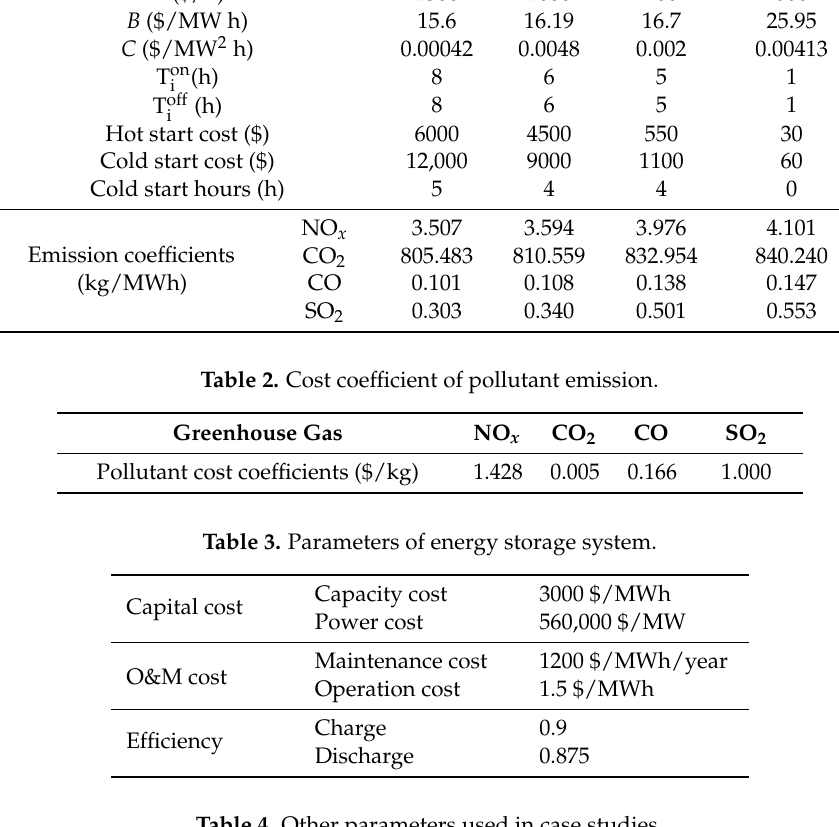
Table 4. Other parameters used in case